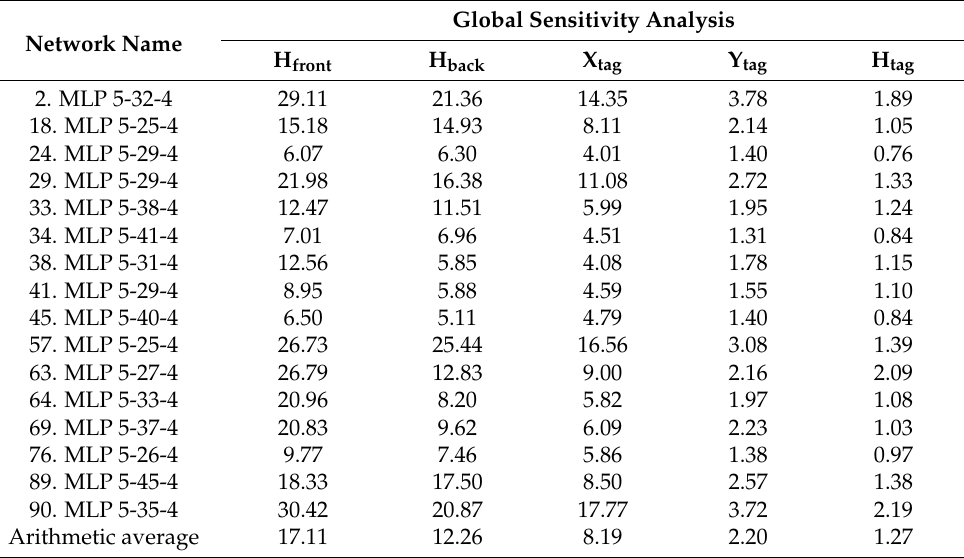
Table 6. The results of global sensitivity analysis for selected 15 neural network